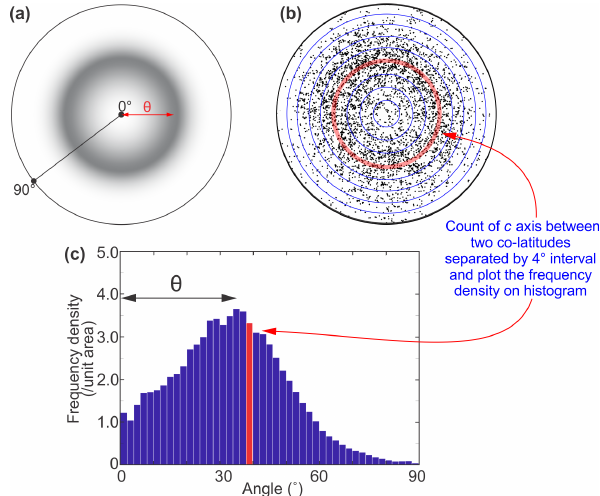
Figure 1. (a) Typical c -axis distribution at high temperatures with compression axis perpendicular to the page. (b) A schematic draw- ing explaining the method used to quantify the distribution of c axes. The c -axis point pole figure taken from PIL178 is used as an exam- ple. The pole figure is plotted with lower hemisphere equal-area projection, and compression axis perpendicular to the page. Only 3000 points are plotted for demonstration purposes. At a given an- gle, a red transparent circle covering co-latitudes separated by 4 ◦ interval is drawn. The points lying between the given co-latitudes (covered by the red transparent circle) are counted. The frequency density of the points is calculated from the normalized counts di- vided by the normalized area between the given co-latitudes. (c) The distribution of c -axis frequency density as a function of angle to the compression axis. The angle corresponds to the peak in the distribu- tion is taken as the opening half-angle θ for the cone (small circle) shaped c -axis distribution. Throughout the text this is referred to as the opening